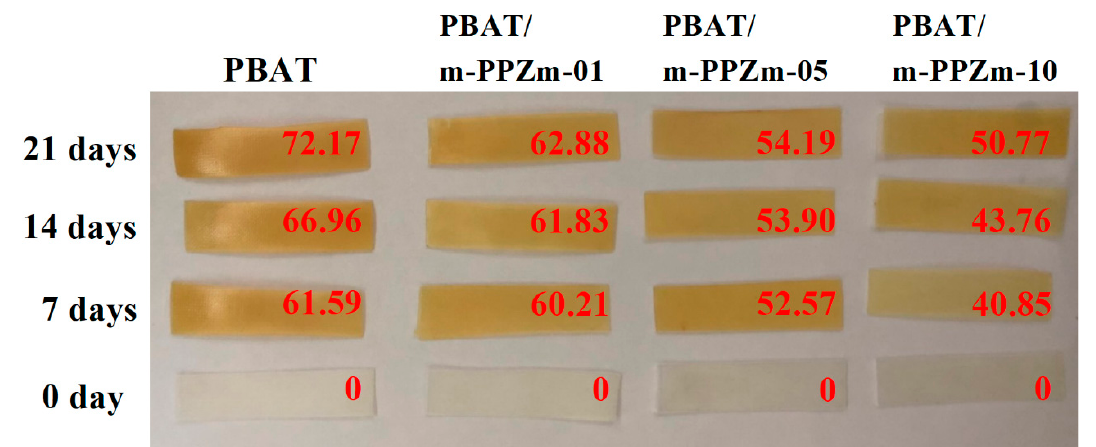
Figure 8. Photos of PBAT and PBAT/m-PPZn composites after 21 days of UV irradiation. The insert value (red) is dYI of each sample.